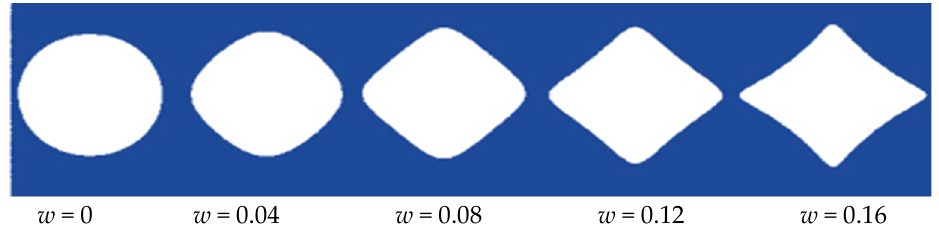
Figure 2. Effect of w on the rectangular hole shape.